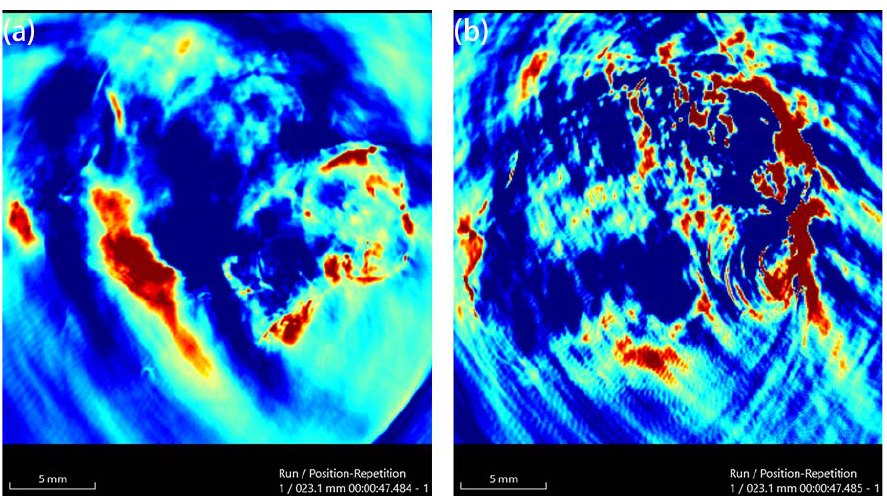
Figure 9. PAI of before ( a ) and after ( b ) injection 180 µ g/mL of Au-UCNPs-DSPE-PEG2K in Balb/c mice.